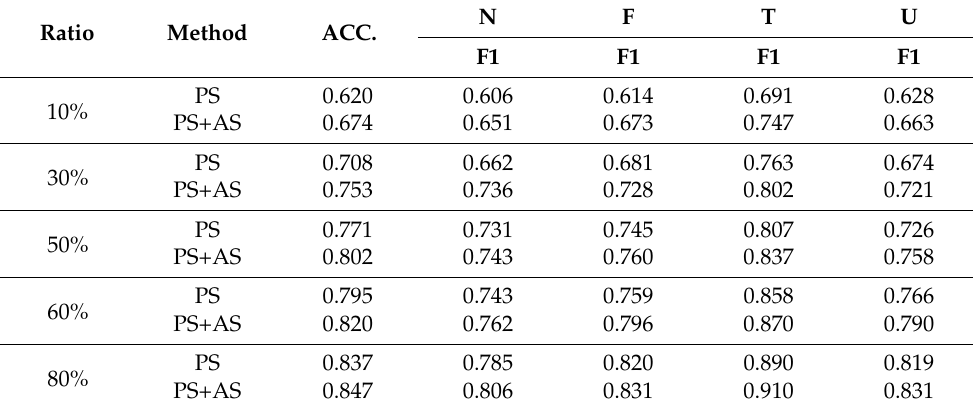
Table 7. Early detection results of rumors on Twitter16.